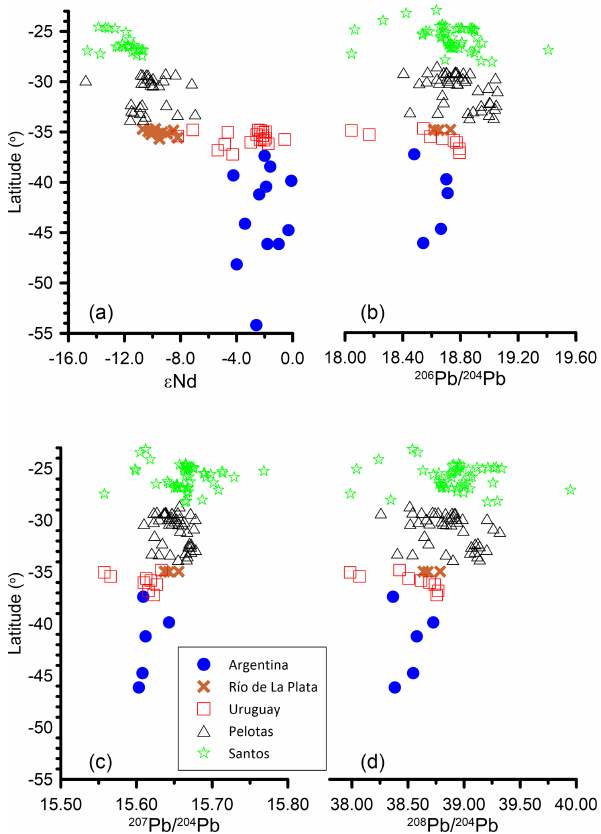
Figure 3. Latitudinal variations of (a) ε Nd, (b) 206 Pb / 204 Pb, (c) 207 Pb / 204 Pb, and 208 Pb / 204 Pb.